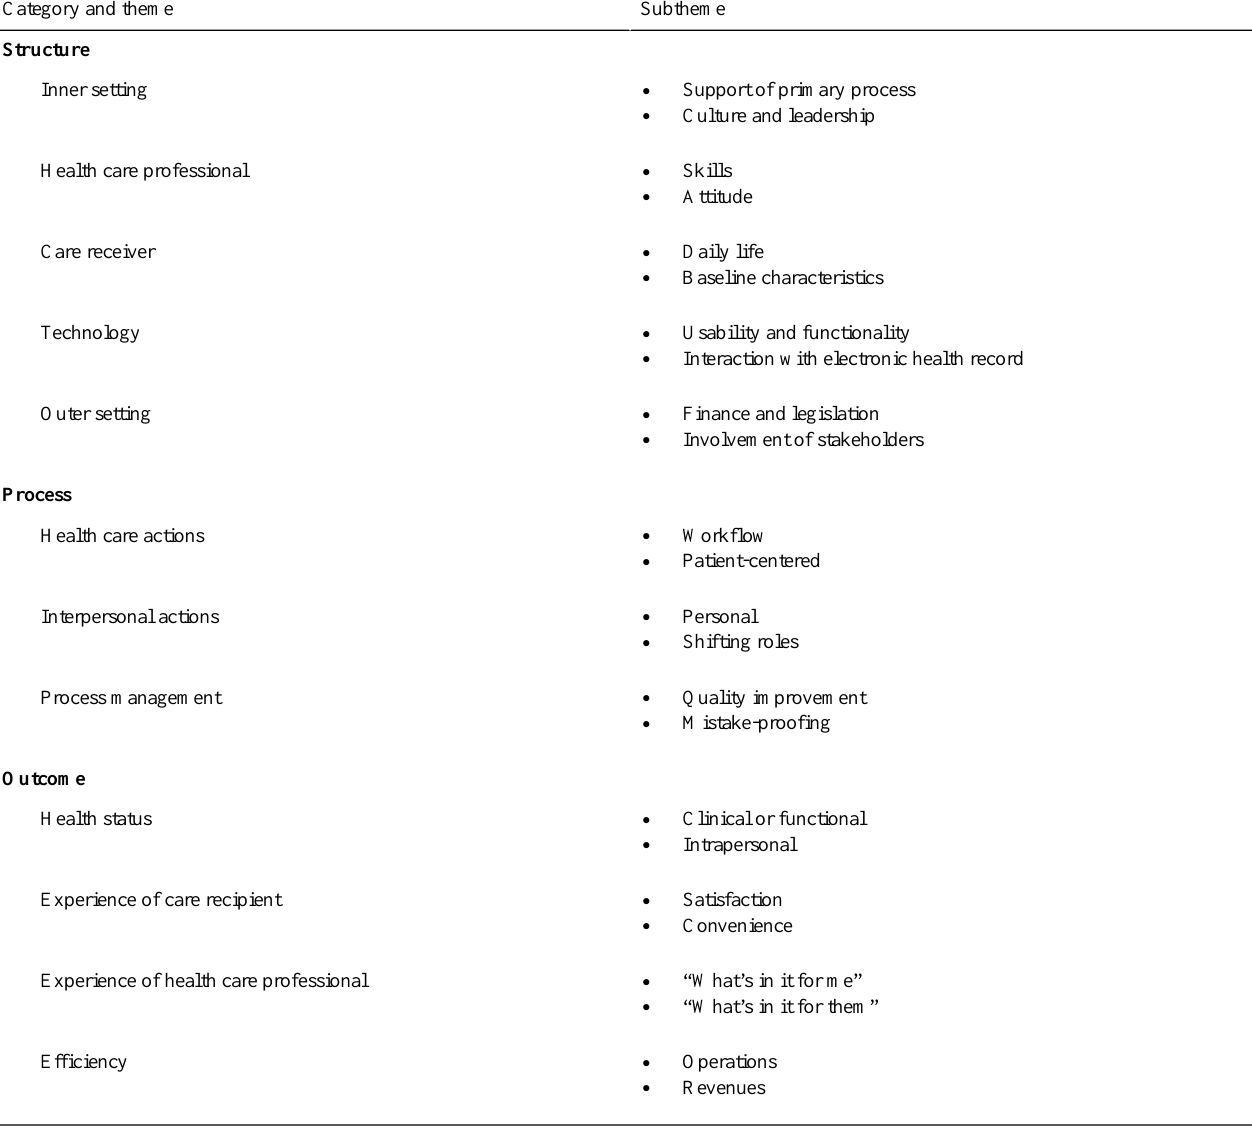
Table 1. Themes and subthemes in the structure, process, and outcome